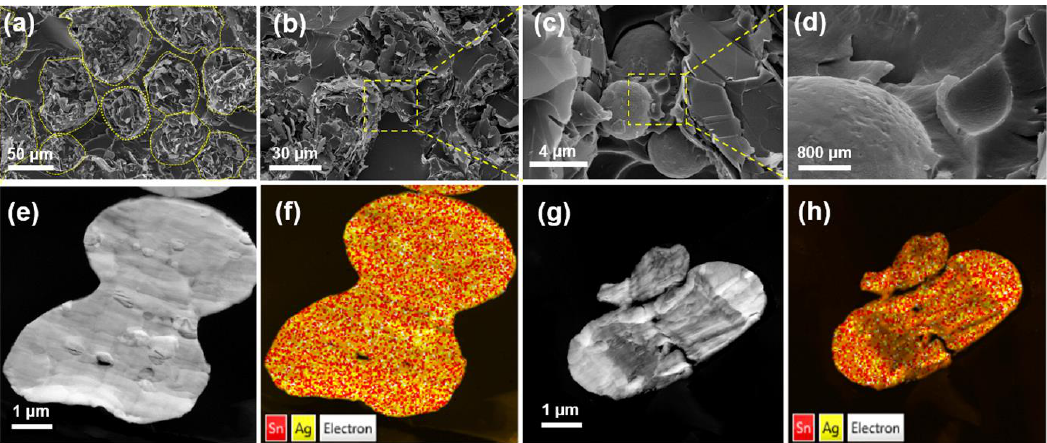
Figure 4. ( a ) Cross-sectional FE-SEM images of epoxy composites filled with 40% filler fraction of hybrid filler (1:1 wt ratio), and ( b – d ) their high magnification images. The yellow part in ( a – c ) shows the bridging morphologies. ( e , g ) Cross-sectional FE-TEM images of epoxy composites filled with 40% filler fraction of hybrid filler (1:1 wt ratio), and ( f , h ) their EDS atomic analysis.